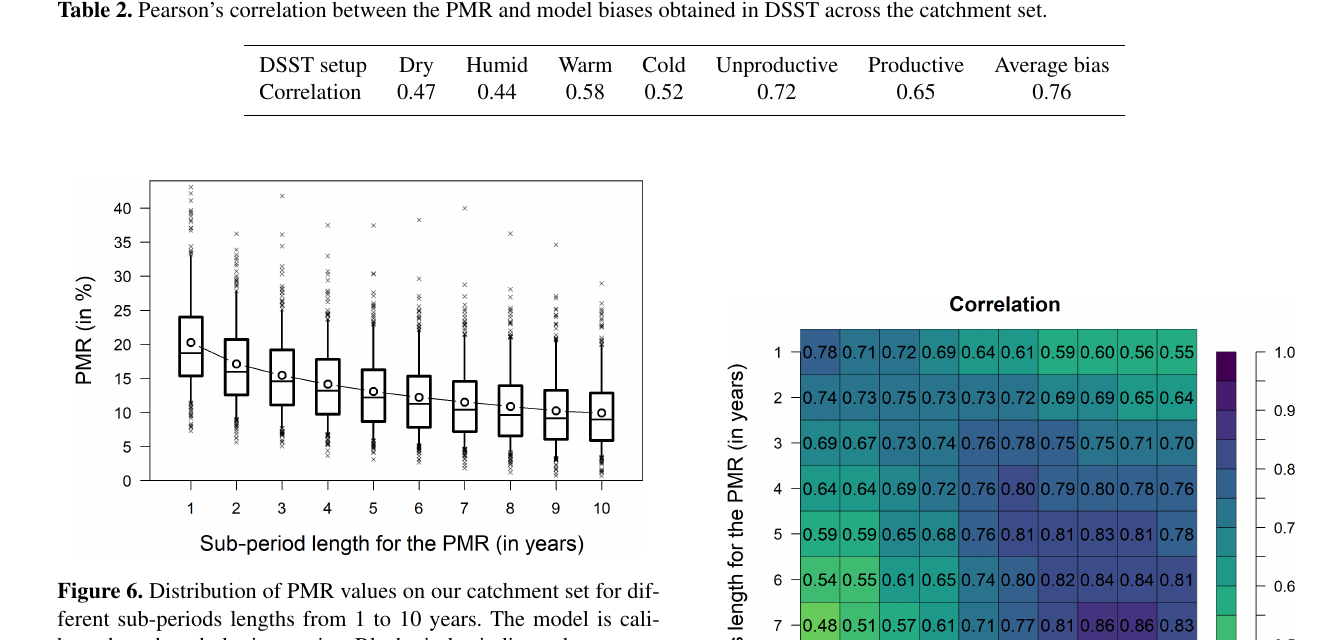
Figure 5. Catchment-wise PMR values against catchment-wise DSST absolute bias (one point per catchment) on average (left) and for each DSST setup (right). The red line corresponds to the fitted linear model relating DSST absolute bias to PMR. Table 2. Pearson’s correlation between the PMR and model biases obtained in DSST across the catchment set.